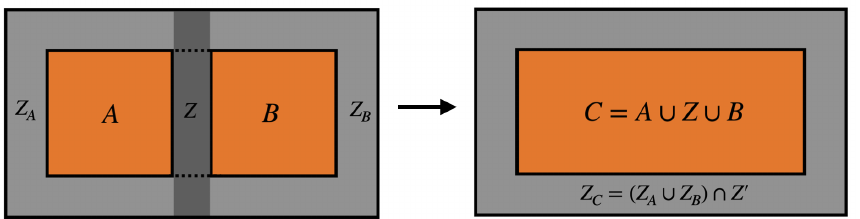
Figure 3 . Geometric configurations appropriate for the definition of concatenability of twist operators. The left hand side represents the existence of twist operators τ g ( A, Z A ) and τ g ( B, Z B ) . The right hand side represents the existence of a twist operator τ g ( C, Z C ) for C = A ∪ B ∪ Z and Z = ( Z A ∪ Z B ) ∩ Z 0 . We say τ g ( A, Z A ) and τ g ( B, Z B ) are “concatenable” if τ g ( AZB, Z A ∪ Z B ) is the product of τ g ( A, Z A ) and τ g ( B, Z B )